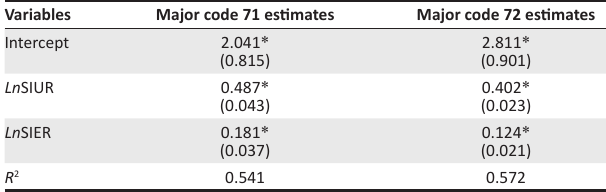
TABLE 5: Regression results of the coefficient of variation vector for employee remuneration levels.